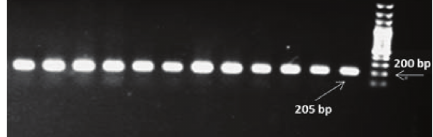
Figure 2: Agarose gel electrophoresis of nested PCR products from clinical specimens using species-specific oligonucleotide pairs for P. falciparum